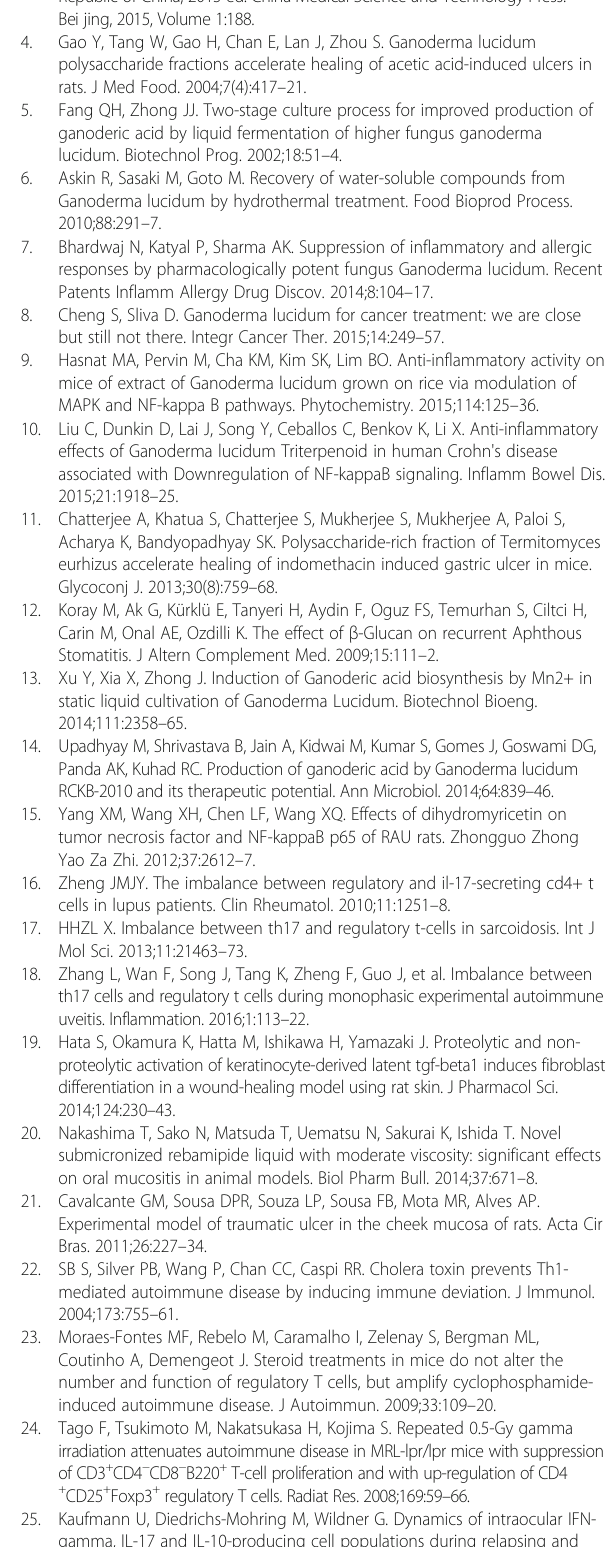
Additional file 4: Table S3. Content determination of Ganoderic Acid A by HPLC spectrophotometry and reproducibility test ( n =3). The content of ganoderic acid A was analysed by HPLC according to the method in the American Herbal Pharmacopoeia and Therapeutic Compendium